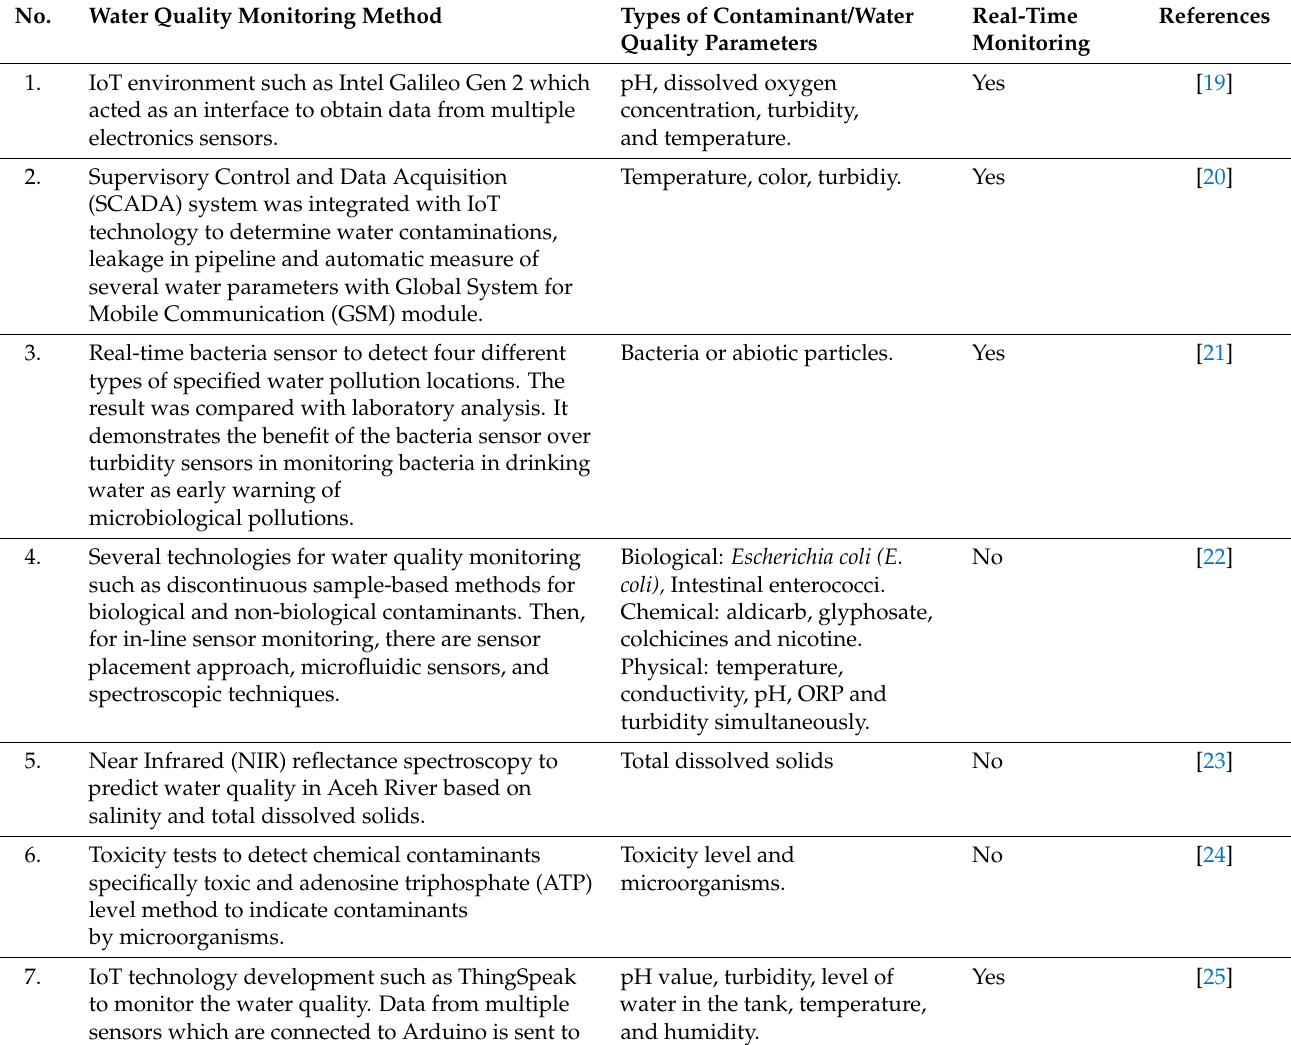
Table 2. Previous works on water quality monitoring